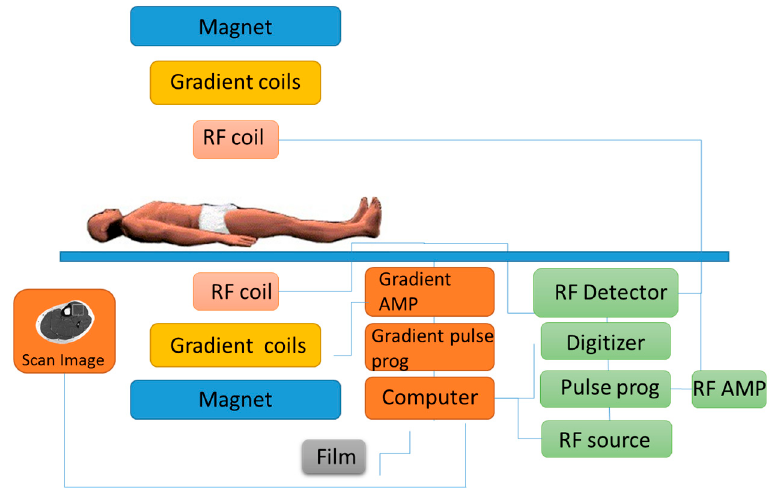
Figure 7. Example of an MRI machine illustrates how the subject is required to be fully stationary during the procedure.